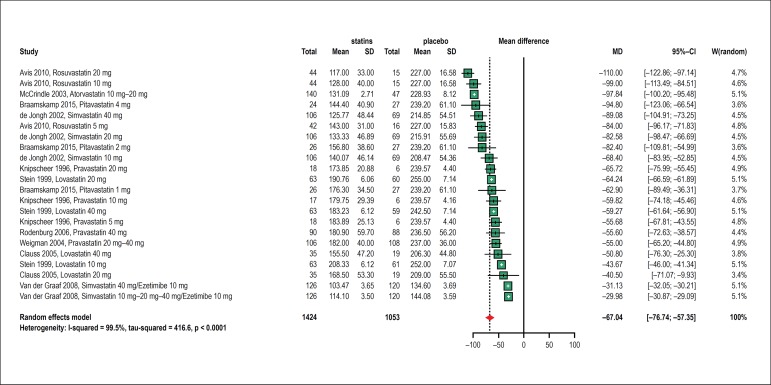
Forest plots showing the effect of statin therapy on low-density
lipoprotein (LDL) cholesterol levels